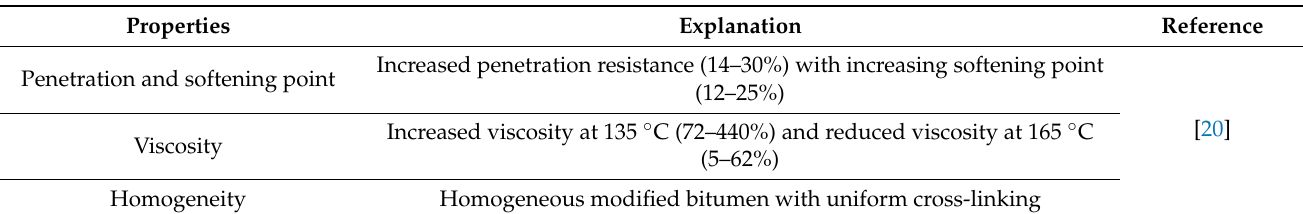
Table 17. Significant properties of xylene